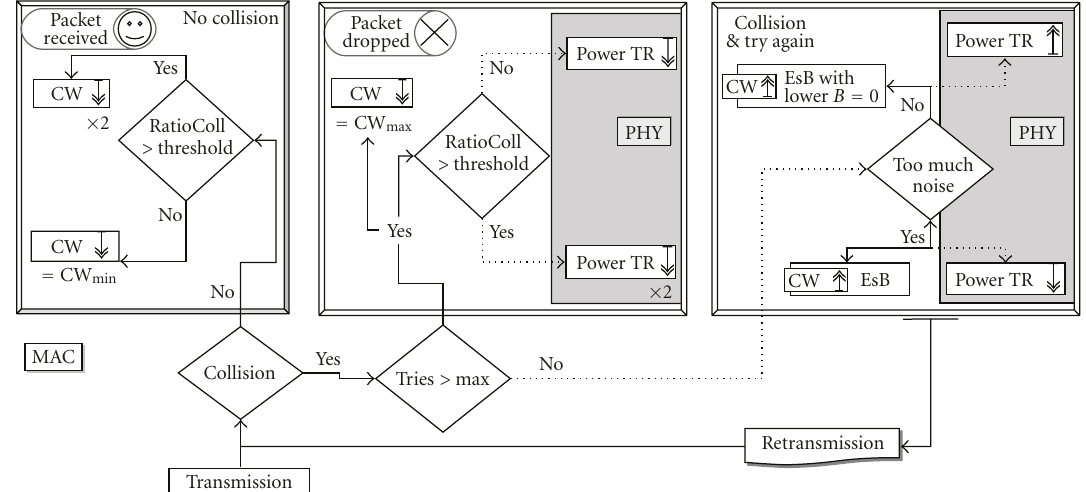
Figure 1: Diagram of the SNAPdMac protocol.